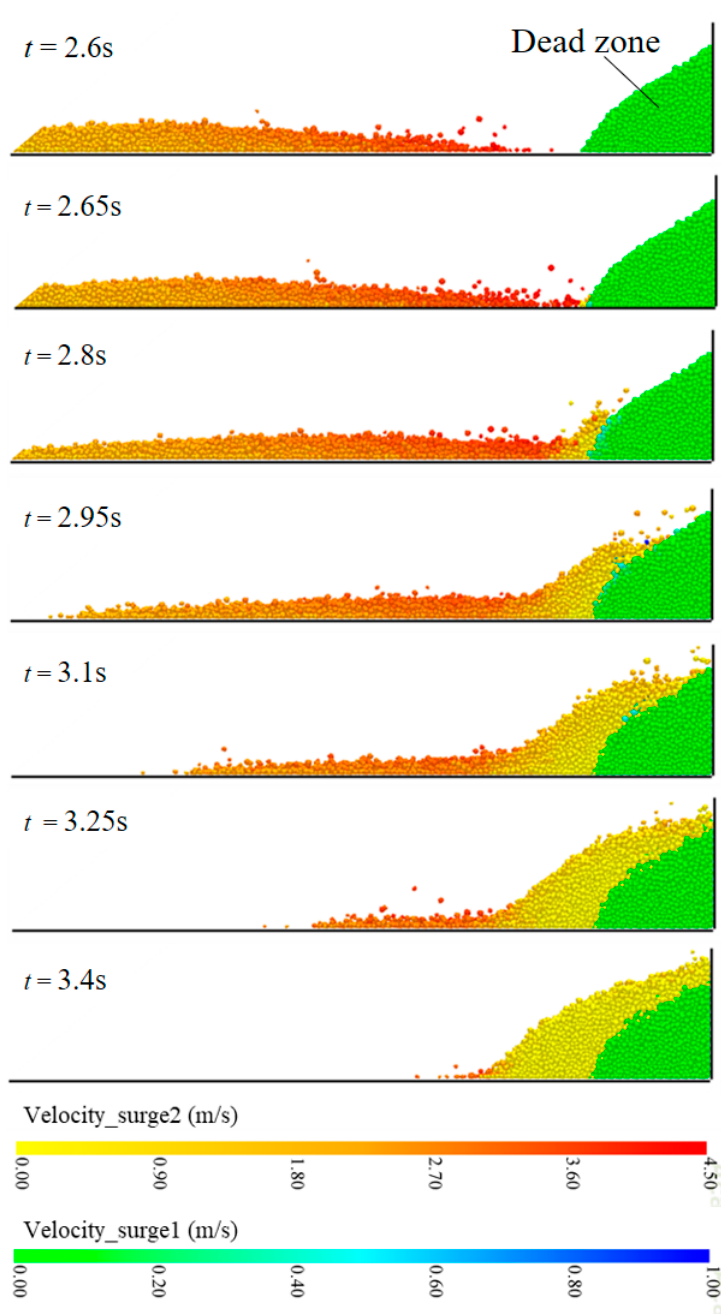
Figure 4. Simulation results showing the interaction between surge2 and the dead zone formed by surge1. The slope angle is 40° and surge volume is 19.8 L.